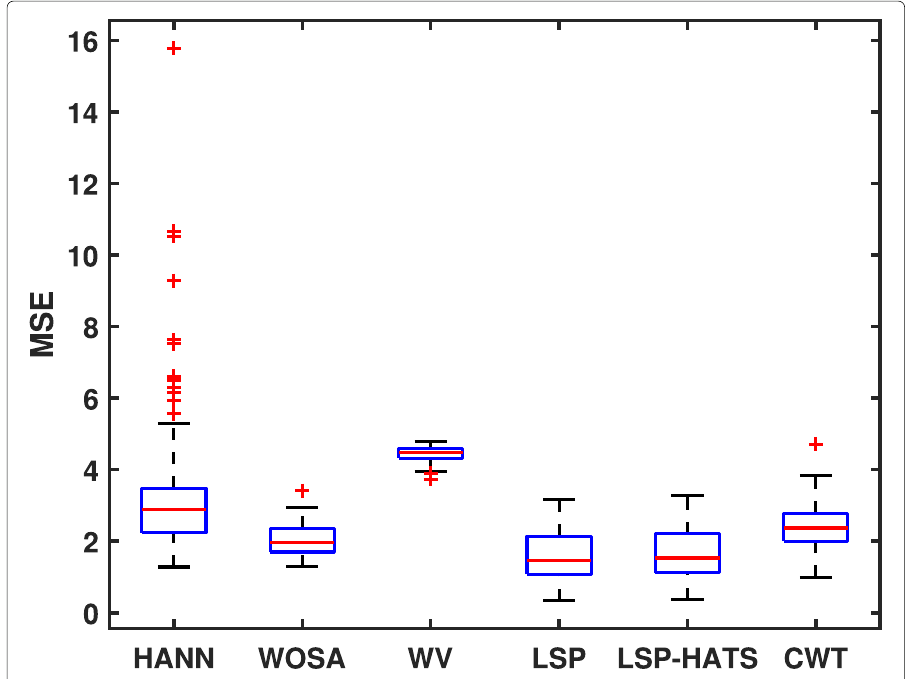
Fig. 4 Boxplots of the MSE on 100 simulations for the spectral estimators considered, all with parameters optimized. Average MSE is mMSE 3.438 for HANN ( N w = 32), 2.061 for WOSA ( K = 8), 4.434 for WV, 1.606 for the true LSP parameter optimal estimator, 1.655 for LSP-HATS, and 2.431 for